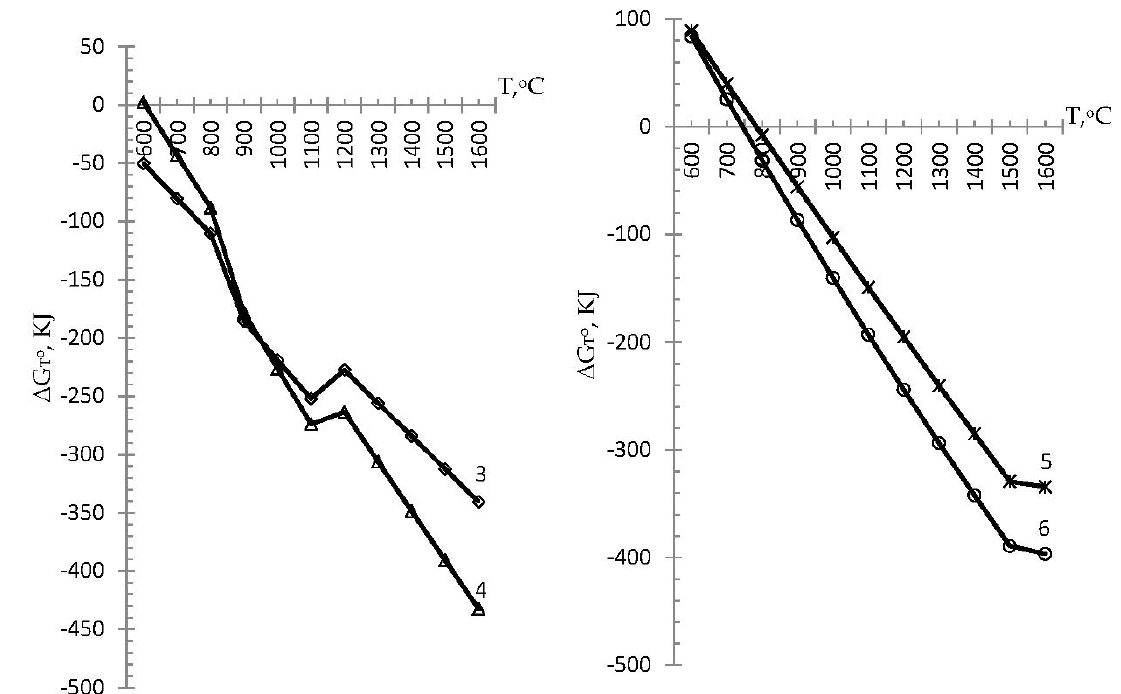
Figure 1. Influence of temperature on the Gibbs energy of the possibility of standard reactions with the formation of clinker minerals.